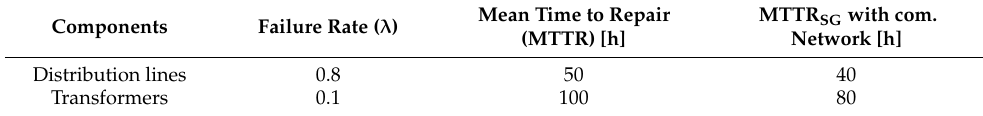
Table 13. Values of the reliability parameters used for the simulations.